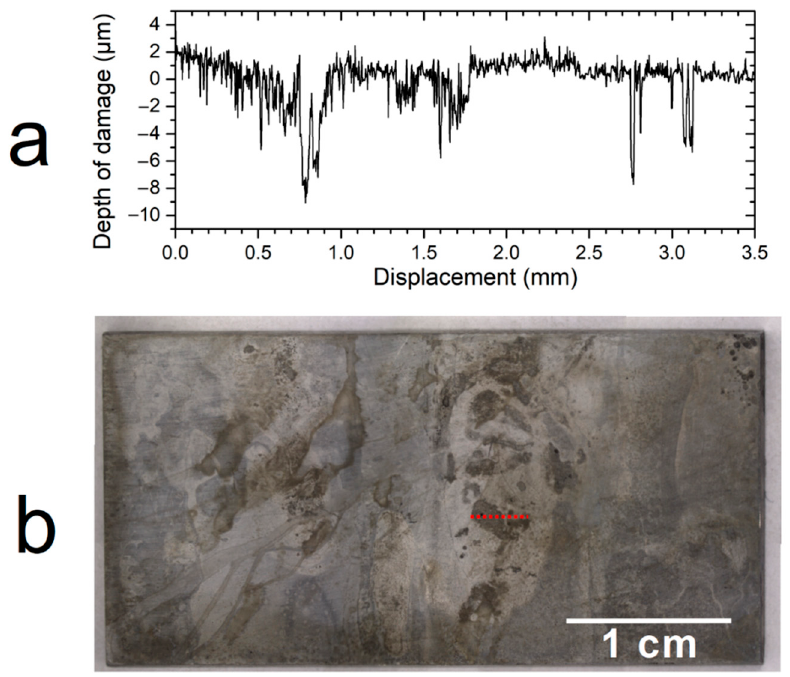
Figure 5. ( a ) Corrosion depth profile obtained in the most degraded area of a carbon steel sample after the experiment and ( b ) image of the coupon surface showing the localization of the analyzed area (red dotted line).